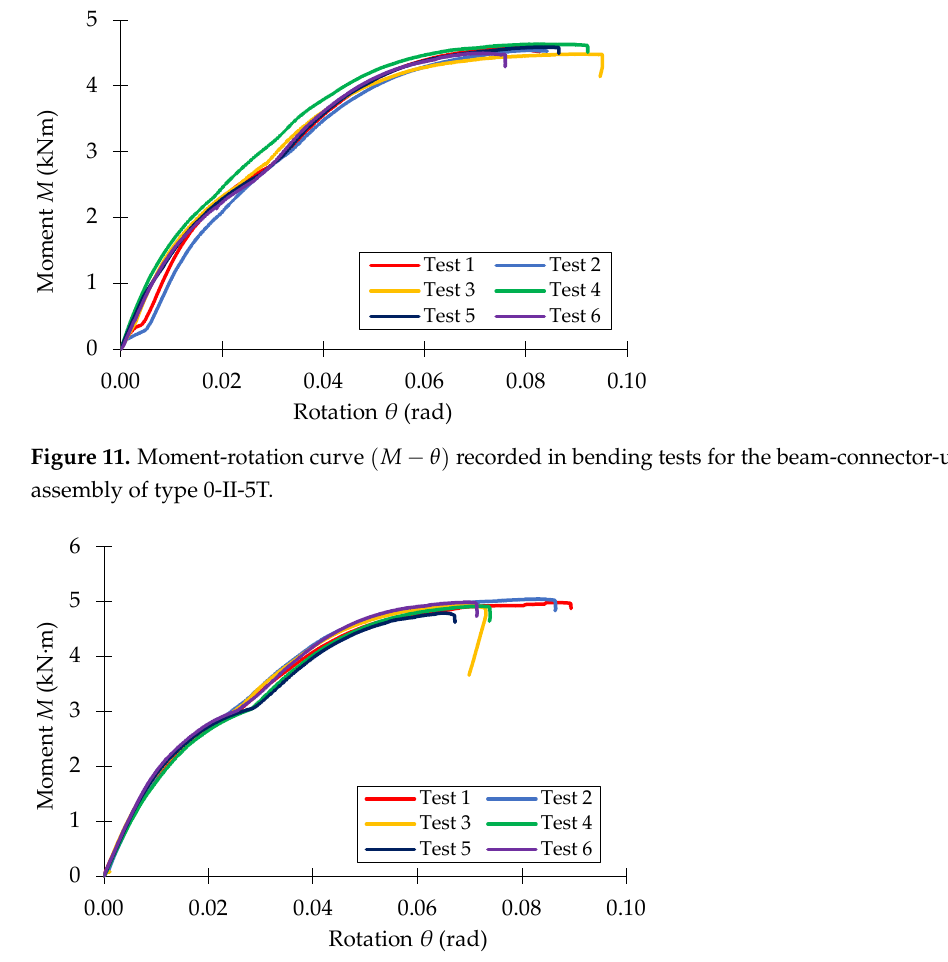
Figure 10. Moment-rotation curve (𝑀 − 𝜃) recorded in bending tests for the beam-connector- upright assembly of type 0-I-5T.